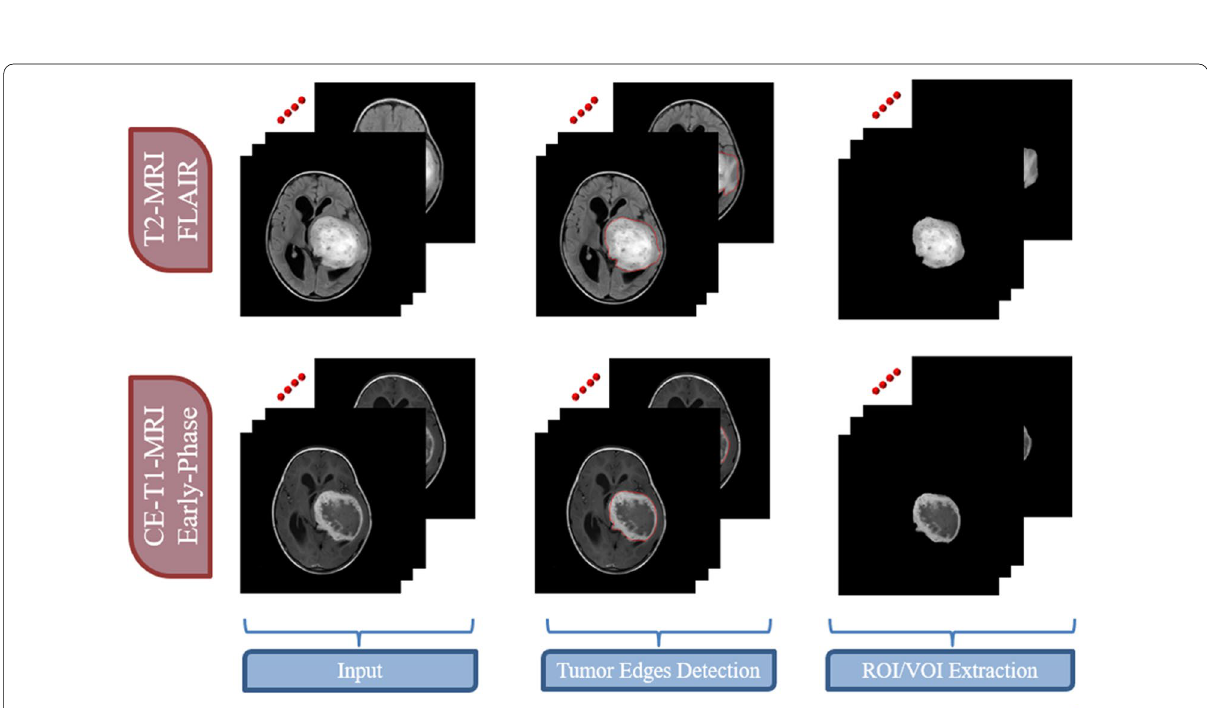
Fig. 3 Manual segmentation for a glioma tumor in two different imaging